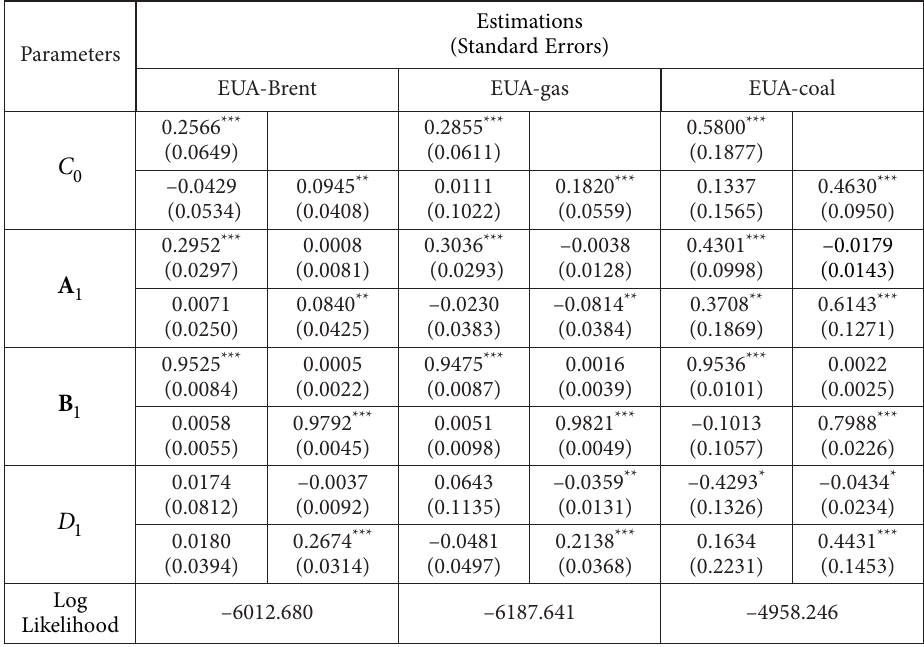
Table 5. Estimation of asymmetric BEKK (1, 1) model to the daily log returns of EUA and brent, natural gas, coal from 2/1/2013 to 17/7/2018 for 1383 observations